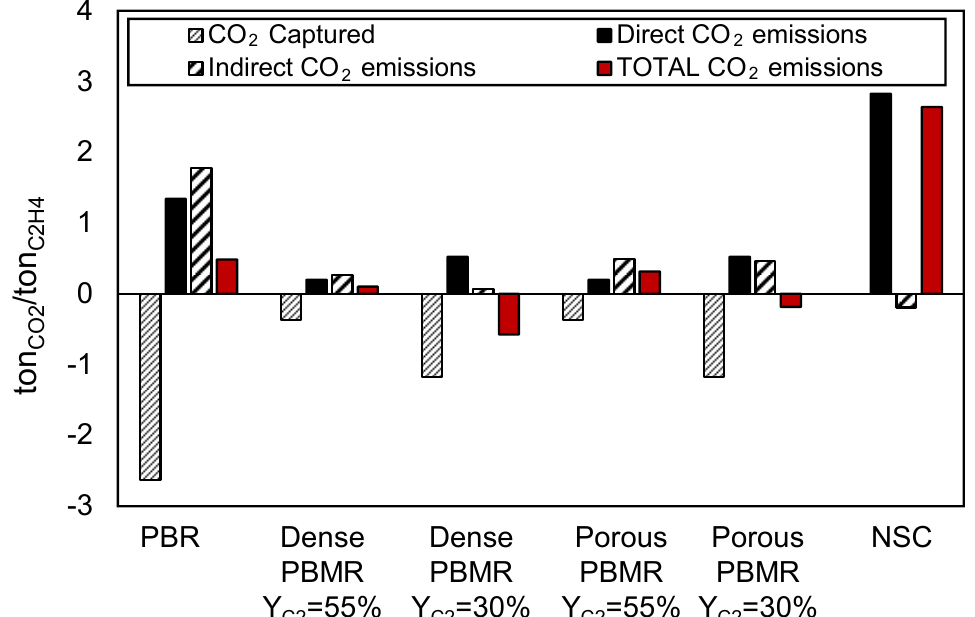
Figure 8. CO 2 captured, direct CO 2 emissions, indirect CO 2 emissions, and total CO 2 emissions (all of them in tonCO 2 / tonC 2 H 4 ) for the five cases considered; packed bed (PBR), dense membranes reactor, dense membranes reactor with a reduced yield, porous membranes reactor, and porous membranes reactor with a reduced yield, and conventional naphtha steam cracking (NSC).